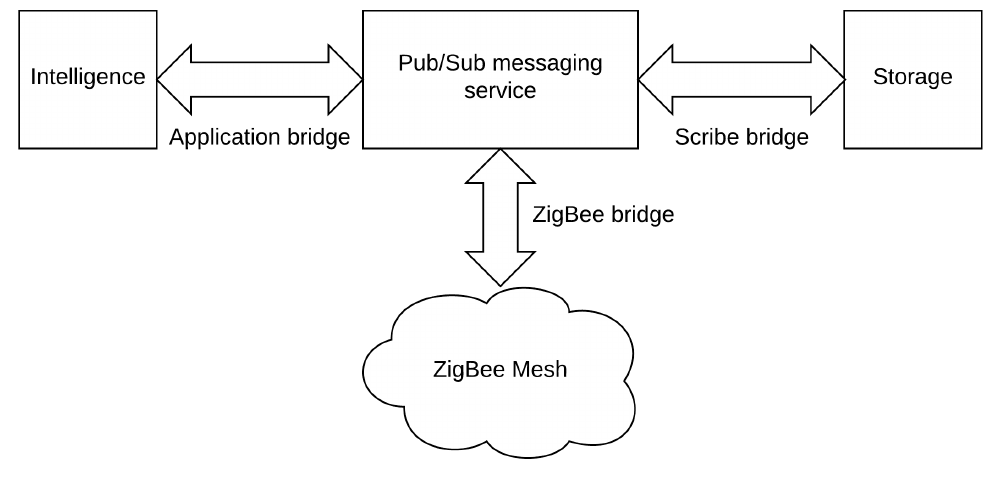
Figure 3. The CASAS architecture. pub/sub: